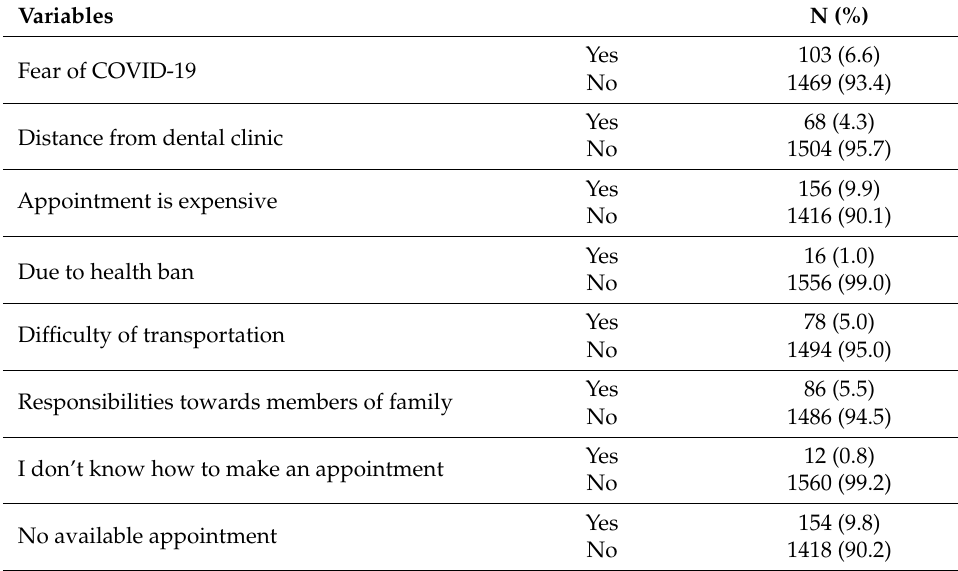
Table 4. Barriers to oral health care reported by parents (N =